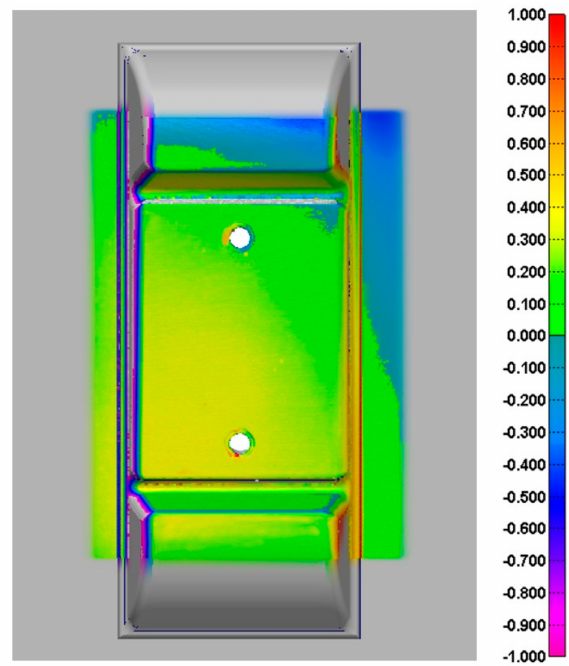
Figure 14. Registration deviation color map (mm).